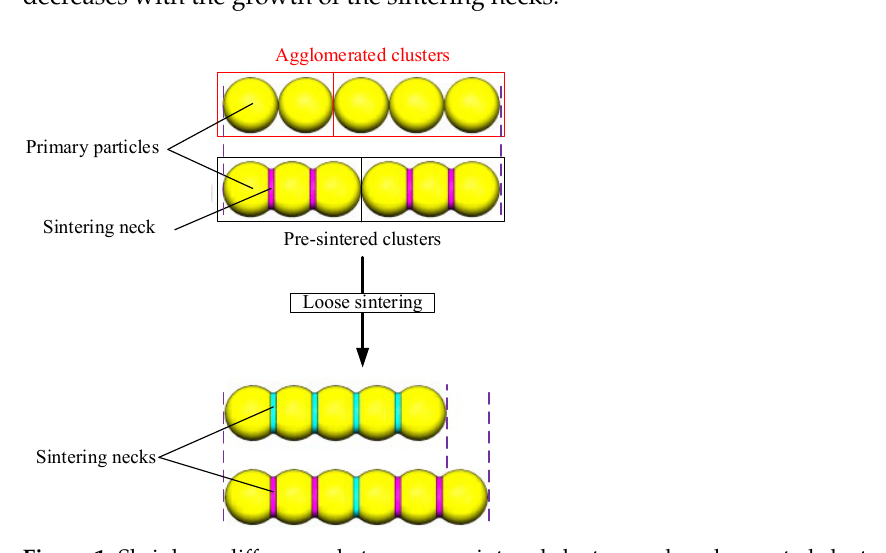
Figure 1. Shrinkage differences between pre-sintered clusters and agglomerated clusters.